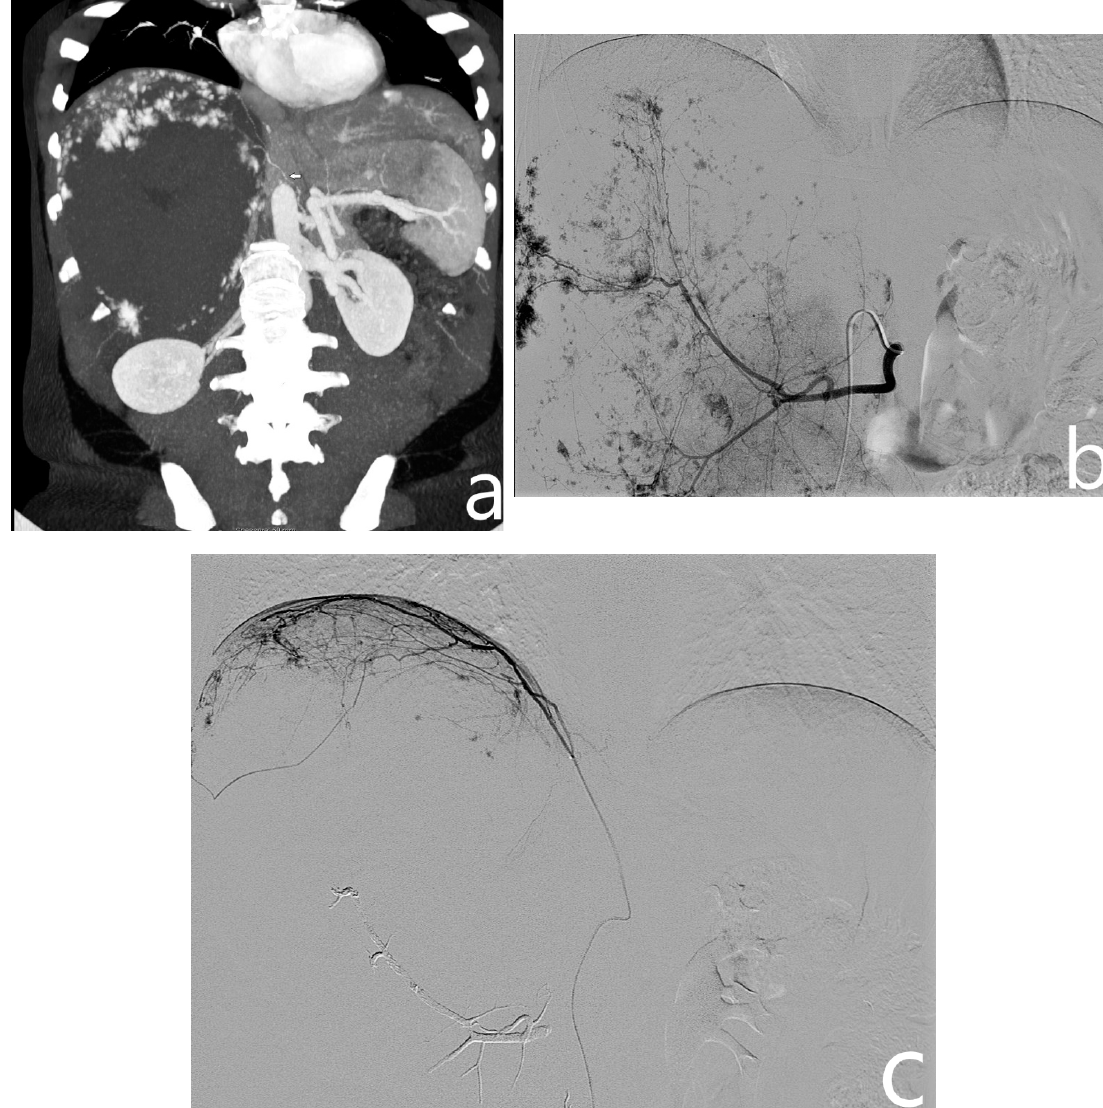
Figure 1. On preoperative CT ( a ), a giant hemangioma of the right liver lobe is identified, with evidence of vascular afference from the right phrenic artery (arrow). On angiography, after identification and embolization of the right hepatic artery ( b ), right phrenic artery is selectively catheterized and embolized with microparticles ( c ).